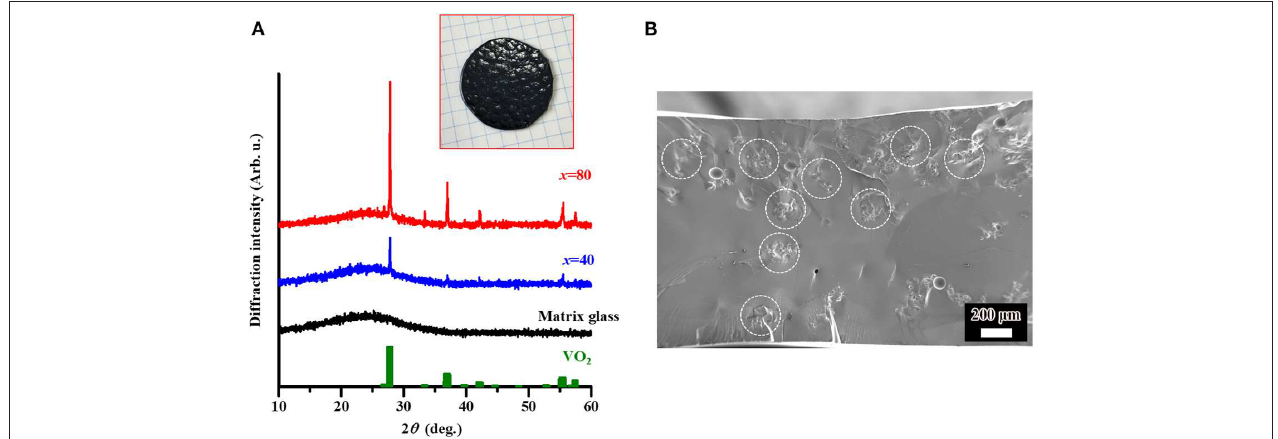
FIGURE 1 | (A) Powder X-ray diffraction (XRD) results of the matrix glass with composition of 15B 2 O 3 -10P 2 O 5 -75V 2 O 5 , and the glasses dispersed with VO 2 powder on the basis of the incorporation method. The values of x represent the additive amount of dispersed VO 2 (in mol%). In addition, the ICDD patterns of VO 2 (43–1051) are included. The inset corresponds to a photo of the dispersed sample with x = 80. (B) Scanning electron microscope (SEM) image of the cross-section of the dispersed sample with x = 40. The encircled region corresponds to the incorporated VO 2